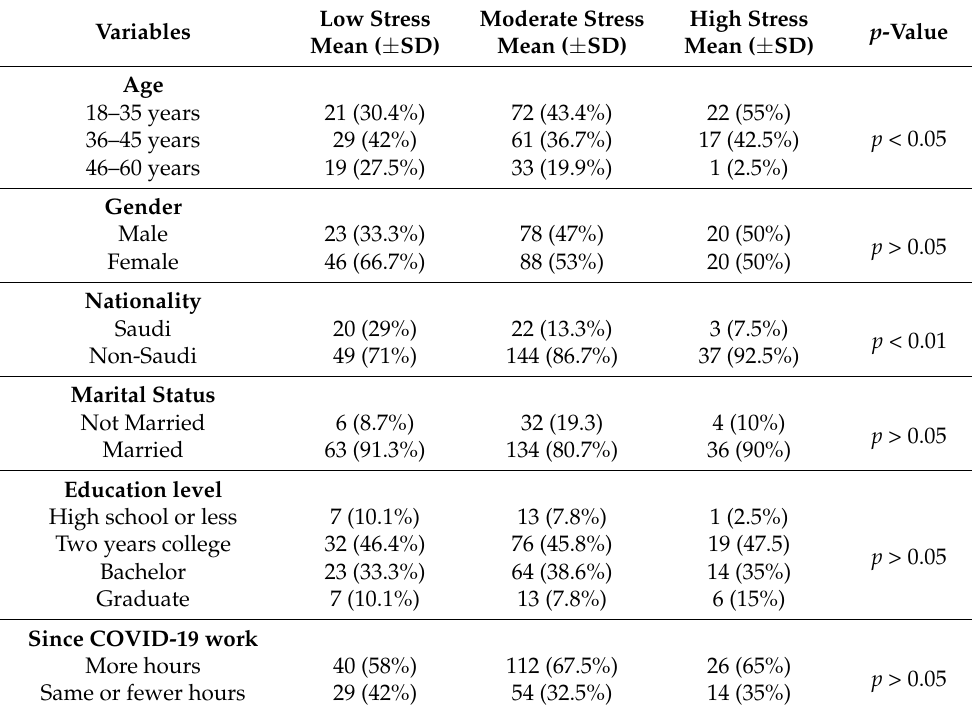
Table 3. Demographic characteristics by stress